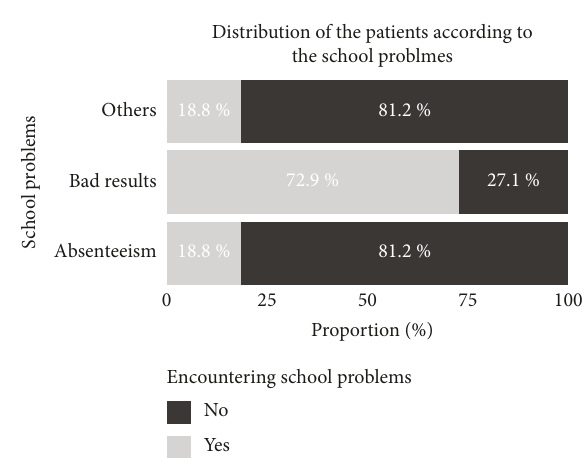
Figure 4: Distribution of the subjects according to their academics